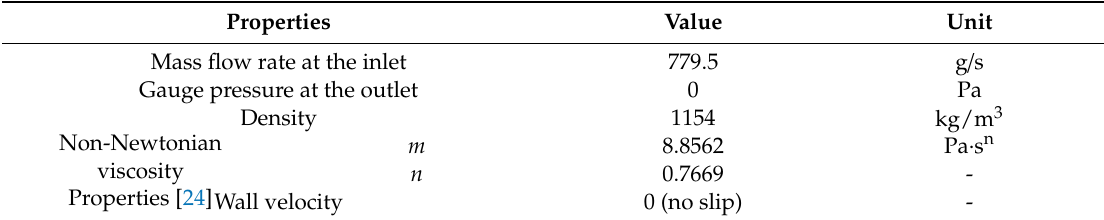
( b ) Figure 4. Verification at the tube section: ( a ) boundary condition, ( b ) grids system. Figure 5. Comparison of Hagaen–Poiseuile flow and numerical result for non-Newtonian fluid. r [mm] 0